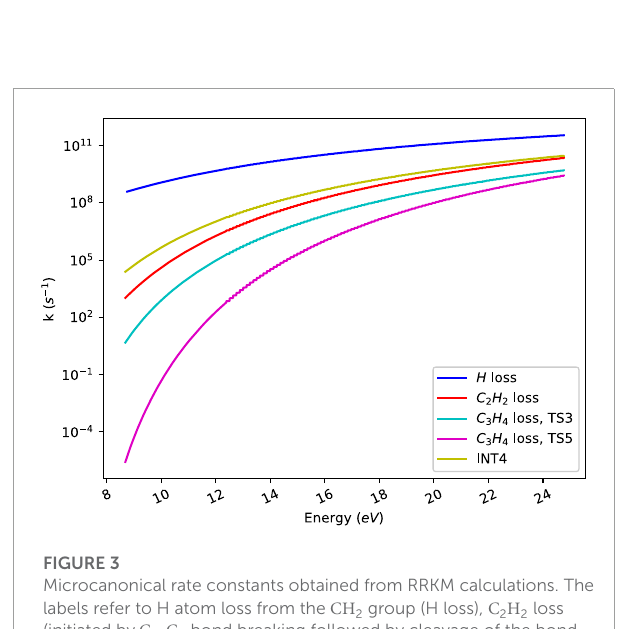
FIGURE 3 Microcanonical rate constants obtained from RRKM calculations. The labels refer to H atom loss from the CH 2 group (H loss), C 2 H 2 loss (initiated by C 1 - C 2 bond breaking followed by cleavage of the bond C 3 - C 4 ), C 3 H 4 loss through transition states 3 (initiated by C 1 - C 2 bond breaking followed by cleavage of the bond C 4 - C 5 ) and 5 (initiated by C 4 - C 5 bond breaking followed by cleavage of the bond C 1 - C 2 ) respectively and formation of the isomer 2-methylphenylacetylene (initiated by C 3 - C 4 bond breaking followed by hydrogen shift from C 2 to C 4 ). See the text for more details.